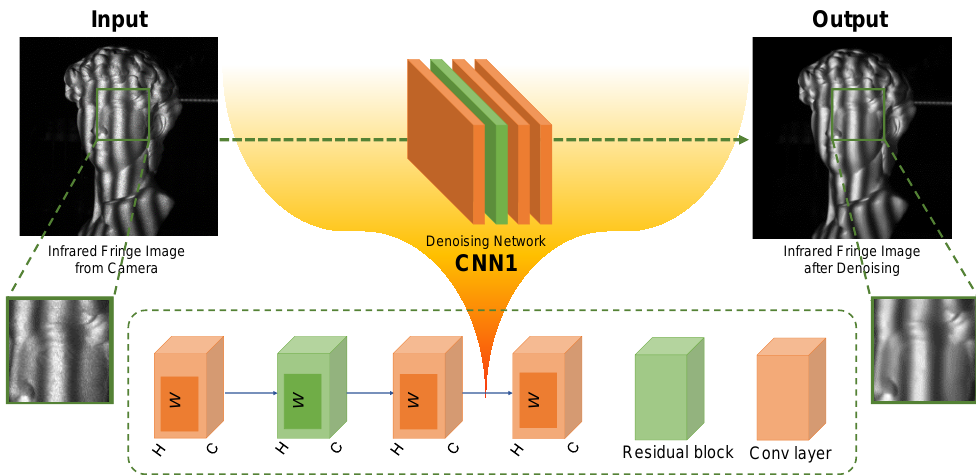
Figure 2. Schematic diagram of the denoising network CNN1, consisting of a convolutional layer and multiple residual